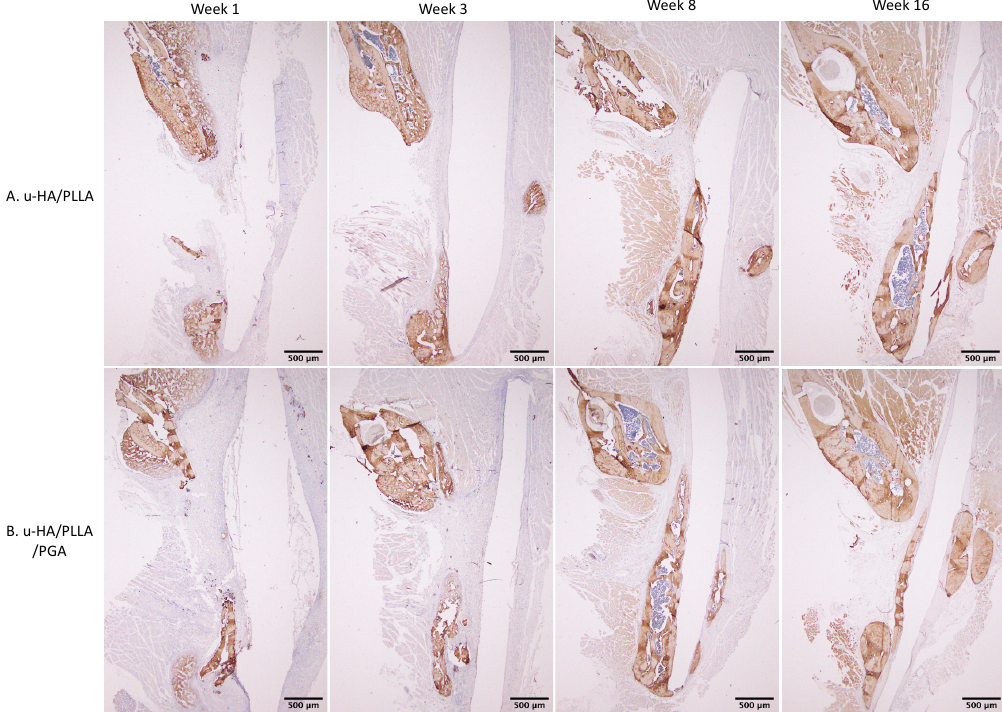
Figure 15. OCN expression in the u-HA/PLLA and u-HA/PLLA/PGA groups. All images were taken at 1.25× magnifica- tion. ( A ) u-HA/PLLA group. ( B ) u-HA/PLLA/PGA group. Scale bar: 500 μ m (black).